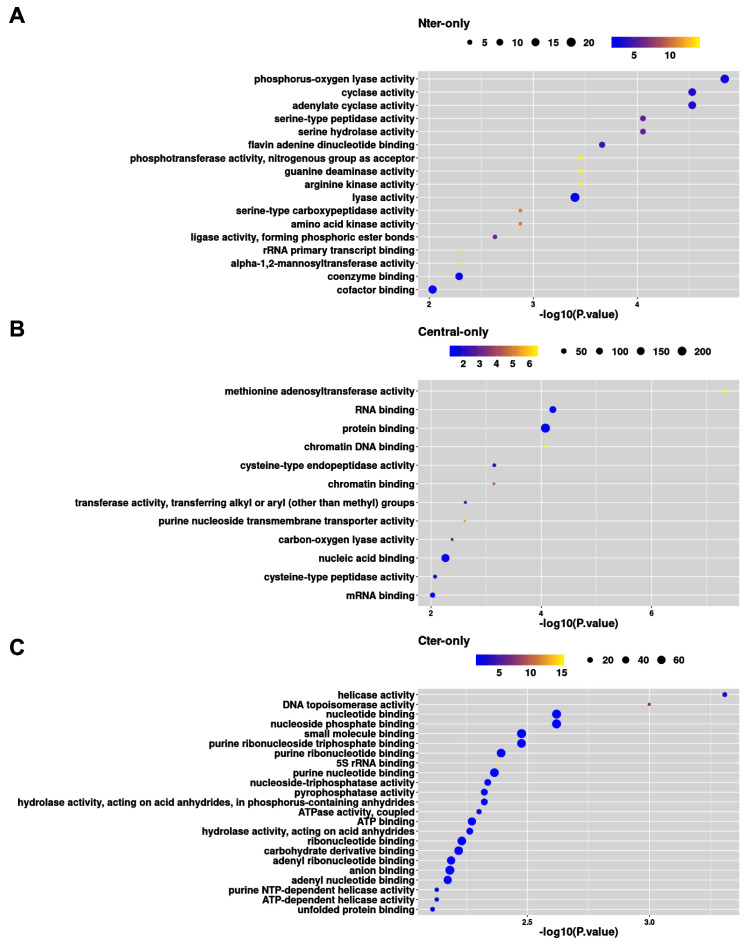
Graphical representation of the -log10 of the p-value obtained with the molecular function Gene Ontology (GO) term analysis for proteins that possess low-complexity regions (LCRs) either only located in their N-terminal (
A), Central (
B) or C-terminal (
C) part. Gradient indicate the log2 fold-change and the size of the dots represent the numbers of proteins.